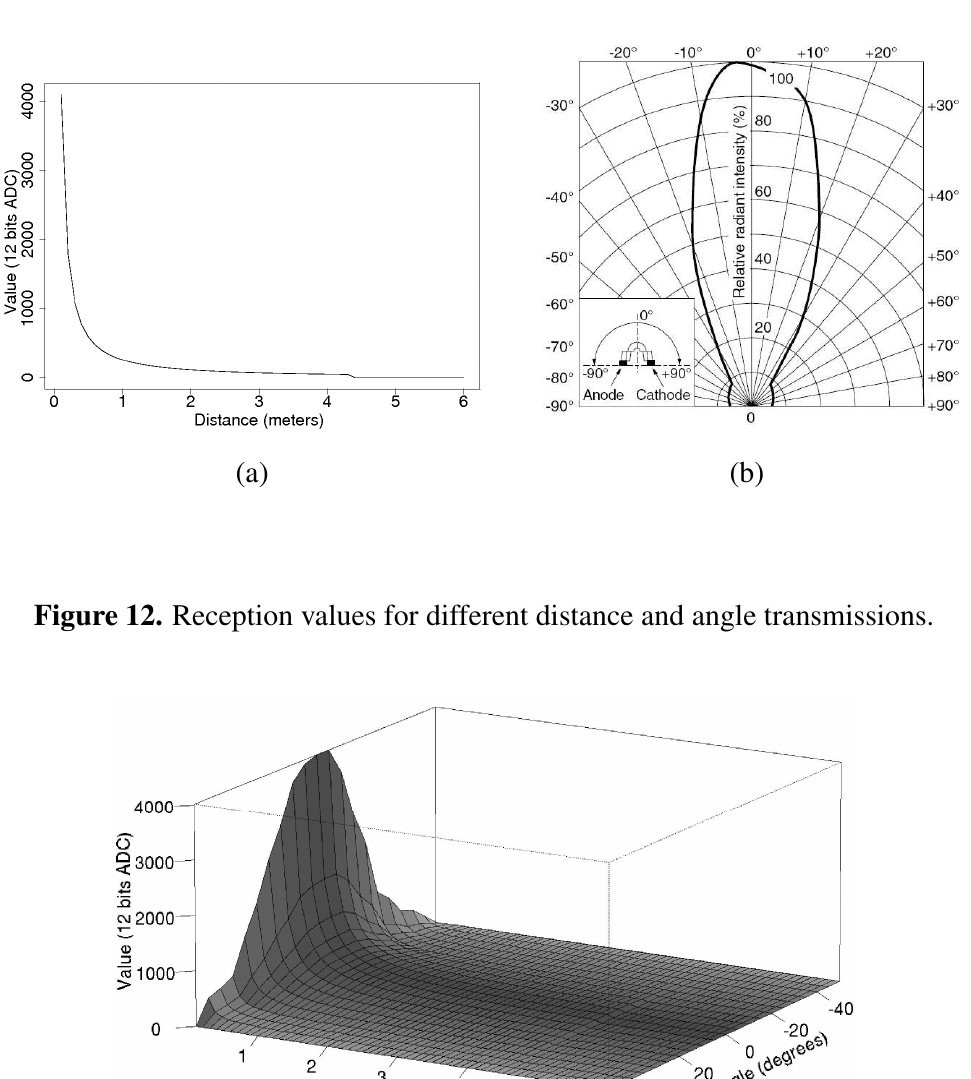
Figure 11. (a) Reception values for different distance transmissions when emitter and re-